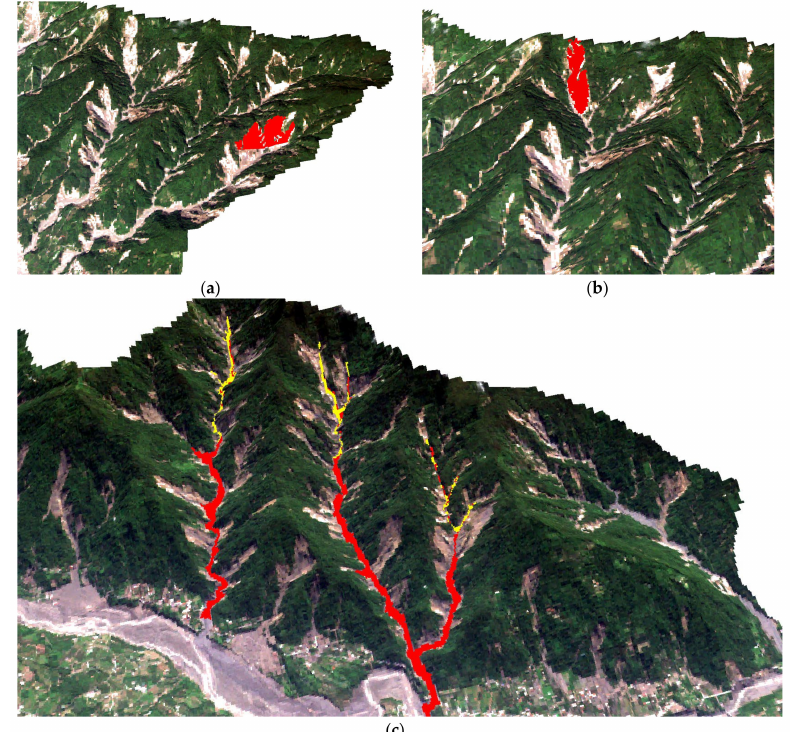
Figure 15. Three-dimensional (3D) view of the No. 3 model for predictions of separating landslide source and runout areas. The landslide source areas of the ( a ) No. 1 and ( b ) No. 2 polygons in the landslide inventory (located region A and B in Figure 14), and ( c ) the runout regions of the No. 1 and No. 2 inventory polygons (located region C in Figure 14). Red and yellow represent correct and incorrect results,